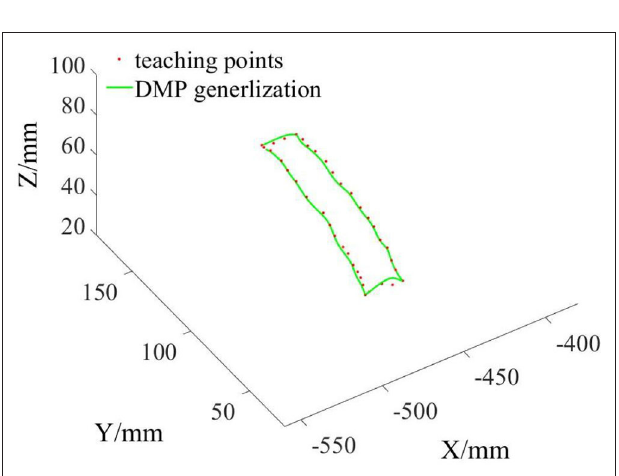
FIGURE 5 | Desired grinding trajectory generating via demonstration and